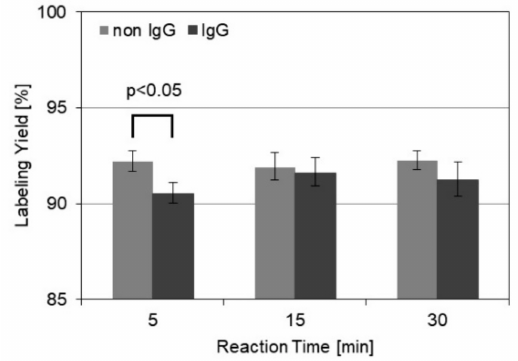
Figure 3. The radiochemical yields of 99m Tc-N 2 S 2 as a function of ( a ) ethylenediaminetetraacetic acid (EDTA)orglucoheptonate(GH)(pH = 7.5, Zn-N 2 S 2 : 1.0 × 10 − 5 M,EDTA:1.5 × 10 − 4 M,GH:1.5 × 10 − 4 M); ( b ) EDTA concentration (pH = 7.5, Zn-N 2 S 2 : 1.0 × 10 − 5 M); ( c ) reaction pH (Zn-N 2 S 2 : 1.0 × 10 − 5 M, EDTA: 1.5 × 10 − 4 M).